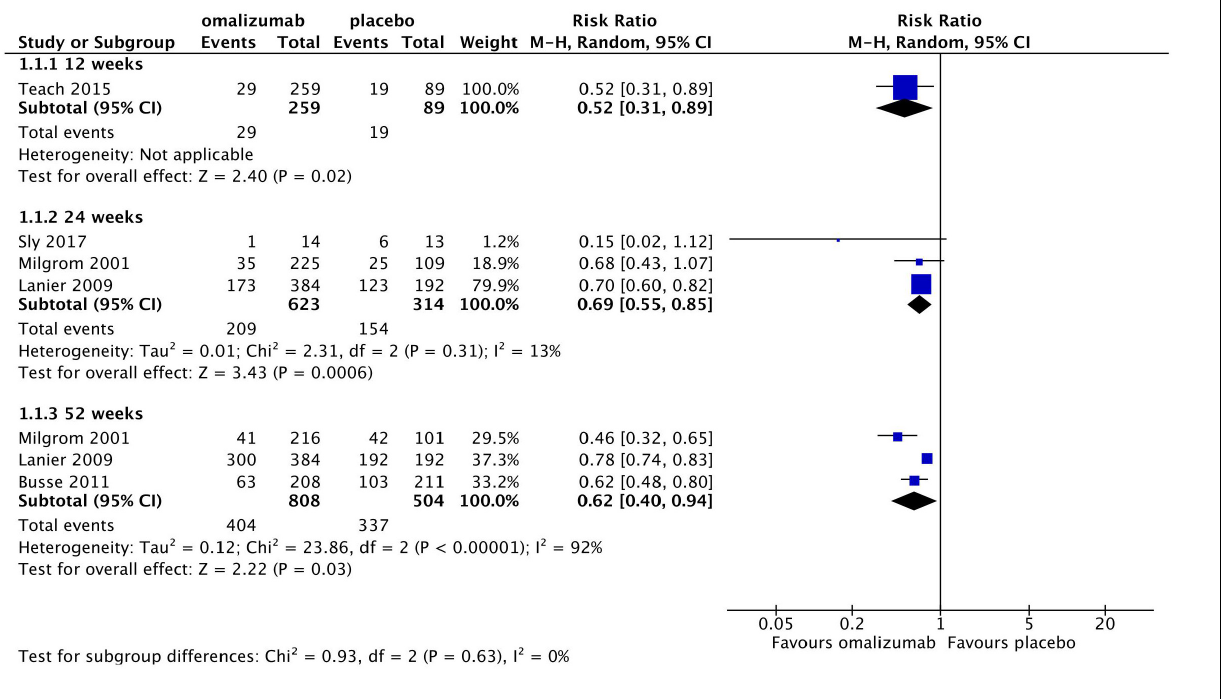
FIGURE 4 | Comparison of omalizumab with placebo for severe asthma